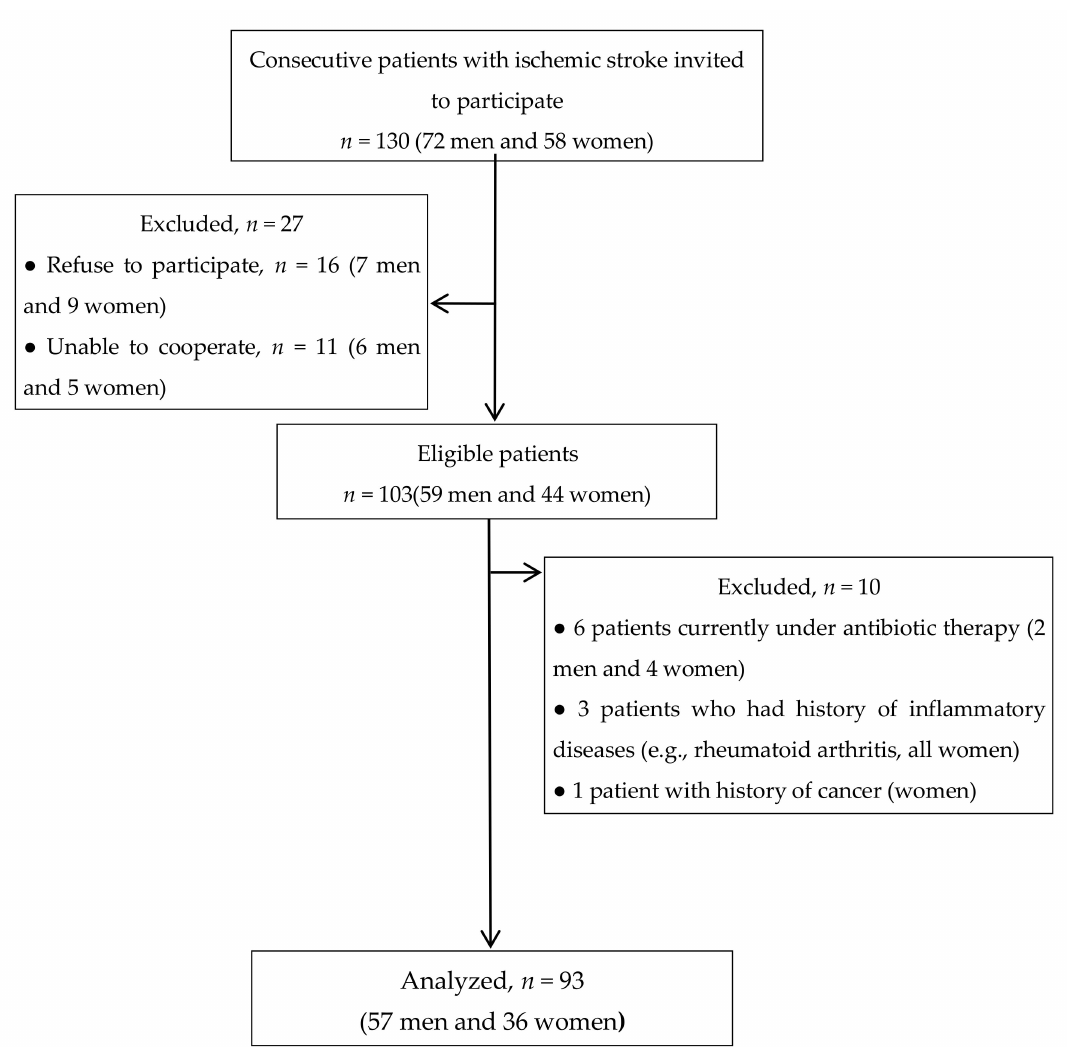
Figure 1. Flow chart of the